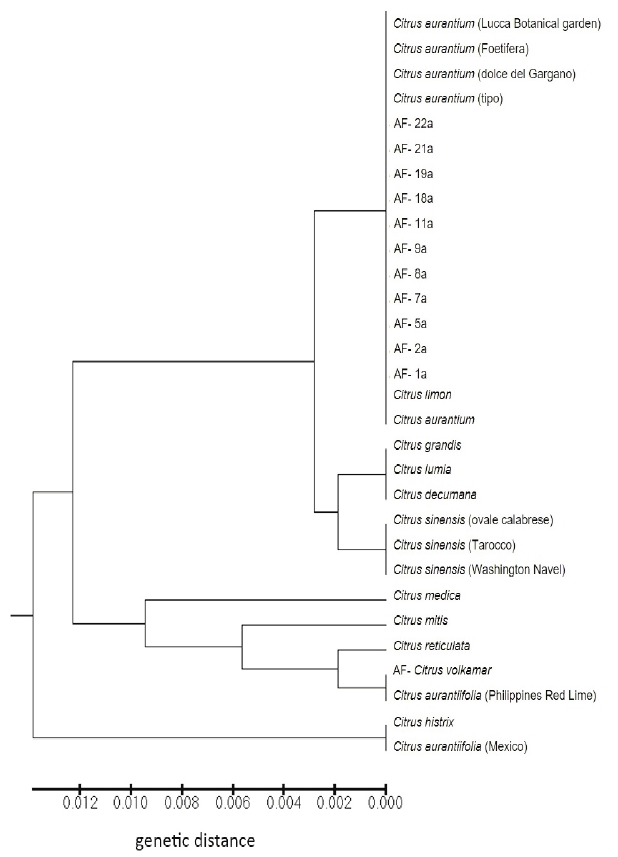
Fig. 3 - UPGMA dendrogram representing the genetic distances among the analysed